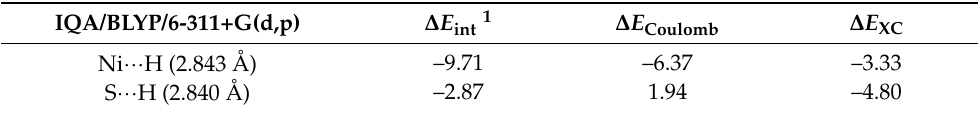
Table 6. IQA Energy Decomposition of the Diatomic Long-range Ni ∙∙∙ H and S ∙∙∙ H Interactions in 1 (the model from Figure 7 is considered).